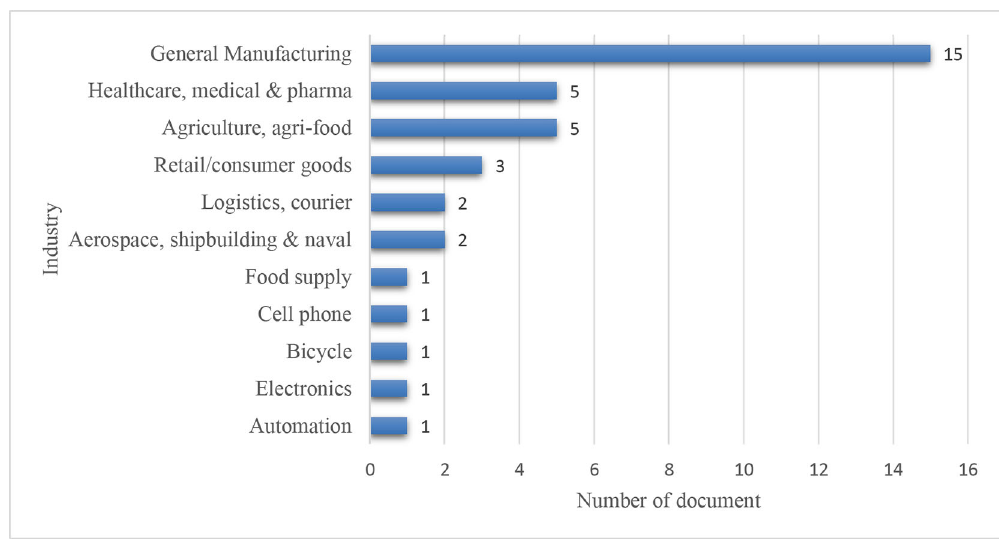
Figure 11. Sector-wise